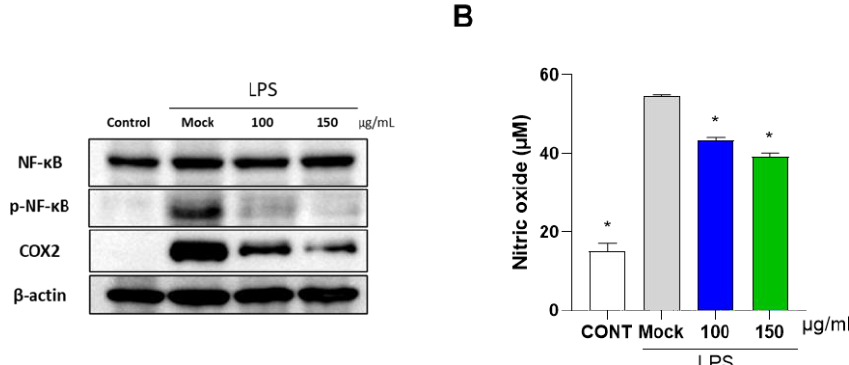
Figure 3. Effect of PG extract on inflammatory signaling cascade of OA in RAW 264.7 cells. RAW 264.7 cells were co-incubated with LPS and different concentrations (100 and 150 µ g/mL) of PG extract (8:2 ratio) for 24 h. ( A ) Protein levels of COX2, NF- κ B and p-NF- κ B were subjected to Western blot analysis. β -actin was used as a loading control. ( B ) NO production was examined using nitrate/nitrite assay. * p < 0.05 vs. Mock, CONT; non-treated group.